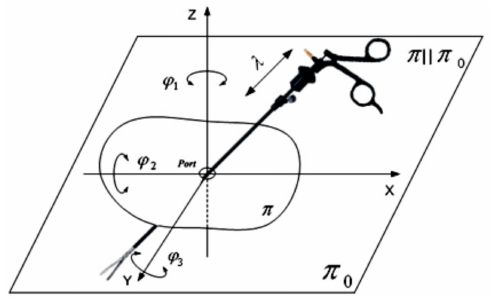
Figure 7. Endoscopic tool with the description of the degrees of freedom in space: three rotations and translations after passing through the port—an access opening in the outer shell of the body.